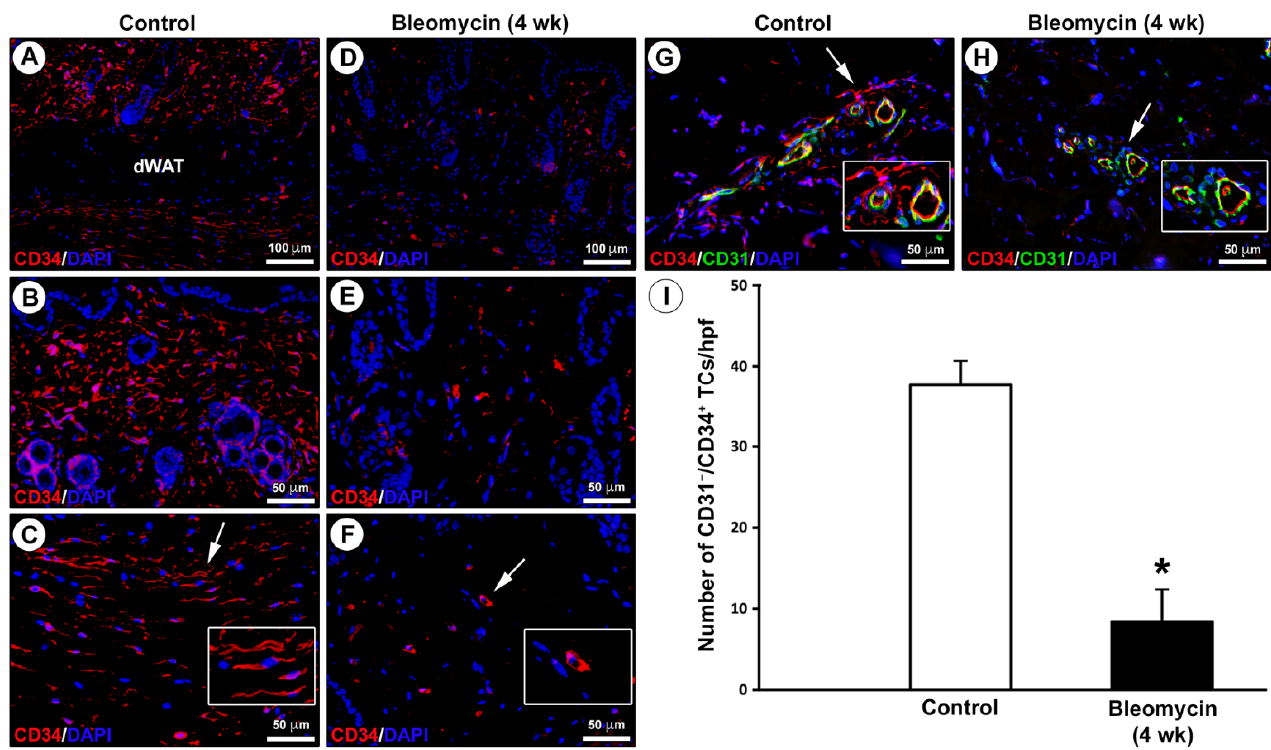
Figure 2. Severe impairment in the dermal network of telocytes (TCs)/CD34 + stromal cells in bleomycin-treated mice. ( A – F ) Representative photomicrographs of skin sections from ( A – C ) control mice and ( D – F ) mice treated with subcutaneous injections of bleomycin for 4 weeks subjected to immunofluorescence staining for CD34 (red) and 4 ′ ,6-diamidino-2-phenylindole (DAPI; blue) counterstain for nuclei. Insets in ( C , F ) represent higher magnifications of the tissue areas pointed by arrows. In control mouse skin, CD34 + stromal cells displaying a spindle-shaped morphology with long cytoplasmic processes and, therefore, identifiable as TCs, form a network that extends in the entire dermis, apart from dermal white adipose tissue (dWAT), and surrounds cutaneous adnexa ( A – C ). A few CD34 + stromal cells with no obvious cytoplasmic extensions are scattered in the dermis of bleomycin-treated mice ( D – F ). Scale bar: 100 µ m ( A , D ), 50 µ m ( B , C , E , F ). ( G , H ) Representative photomicrographs of skin sections from ( G ) control mice and ( H ) bleomycin-treated mice double immunostained for CD34 (red) and CD31 (green) with DAPI (blue) counterstain. Insets in ( G , H ) represent higher magnifications of the dermal tissue areas pointed by arrows. In control mouse dermis, TCs are identifiable as CD31 − /CD34 + stromal cells; endothelial cells of blood microvessels are CD31 + /CD34 + ( G ). In the dermis of bleomycin-treated mice, CD31 − /CD34 + TCs are very few or even almost undetectable ( H ). Scale bar: 50 µ m ( G , H ). ( I ) Quantitative analysis of CD31 − /CD34 + TCs per high-power field (hpf). Columns represent the mean, and whiskers represent the standard error of the mean; n = 6 mice in each group. * p < 0.001 vs. control (unpaired Student’s t -test). wk,